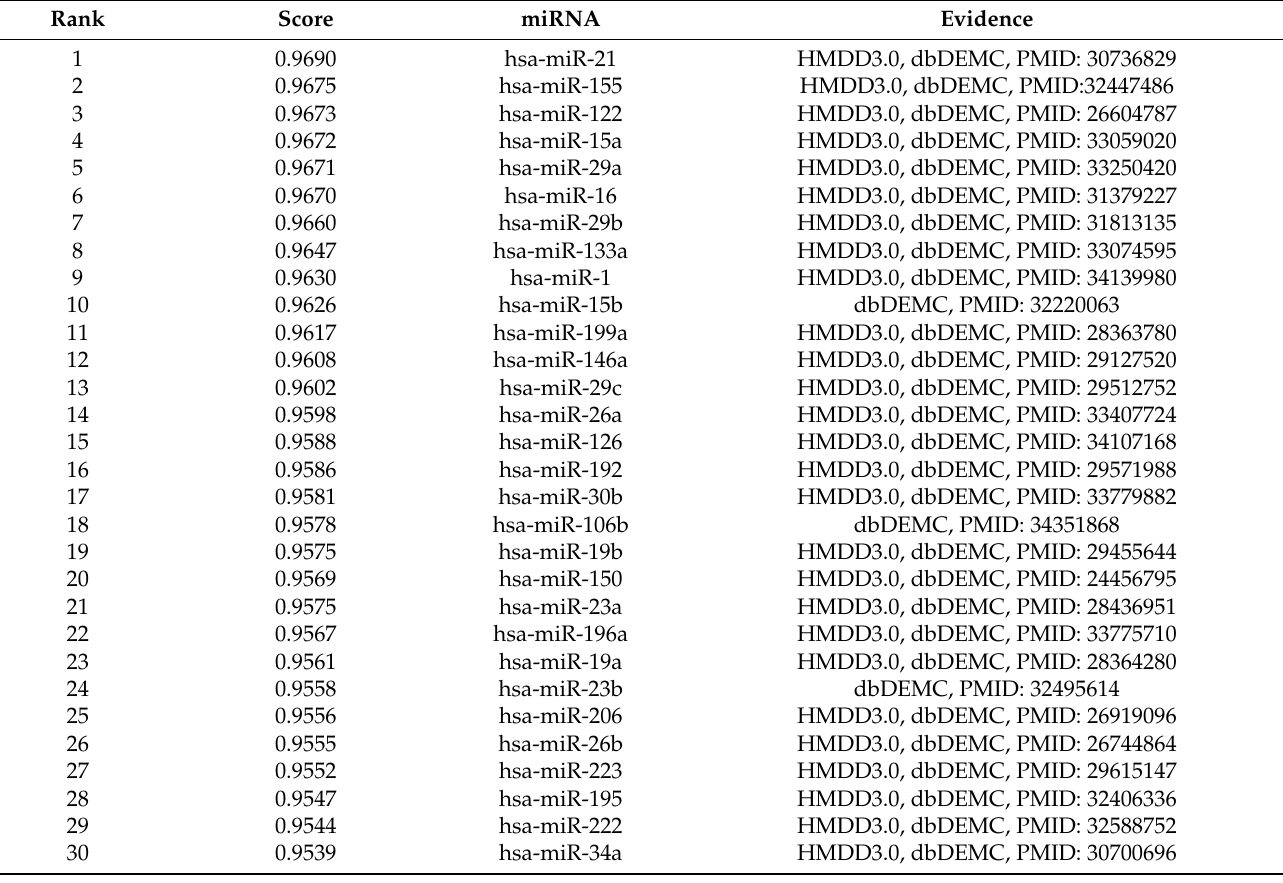
Table 4. Top-30 Predicted Associations of Lung